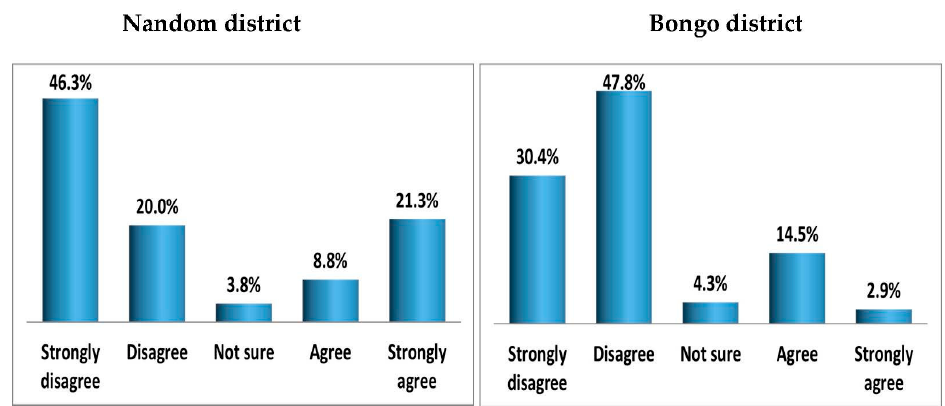
Figure 6. Average annual income from farming in the districts.